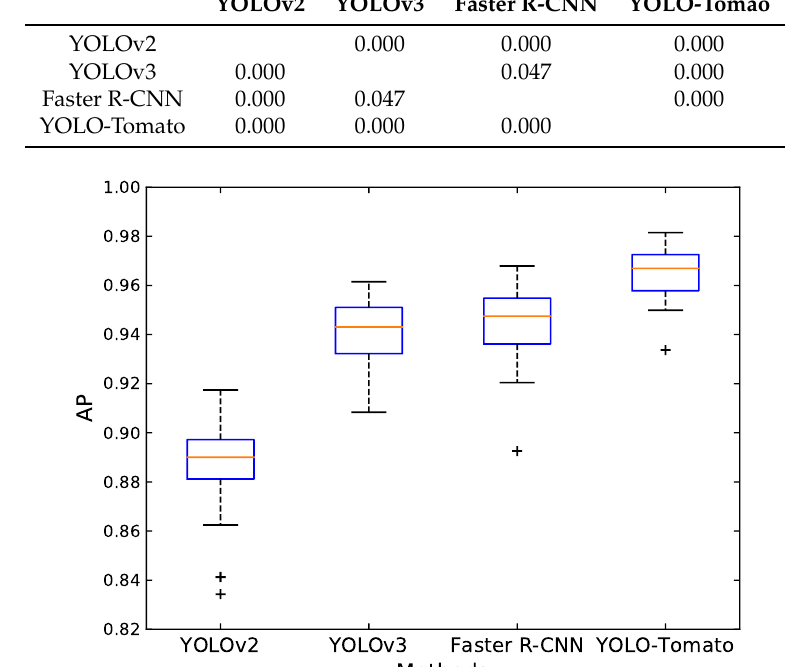
Figure 17. The AP of different methods performed on the 30 sub-datasets displayed using boxplots. The red lines indicate the median values of AP, and ”+” indicates the